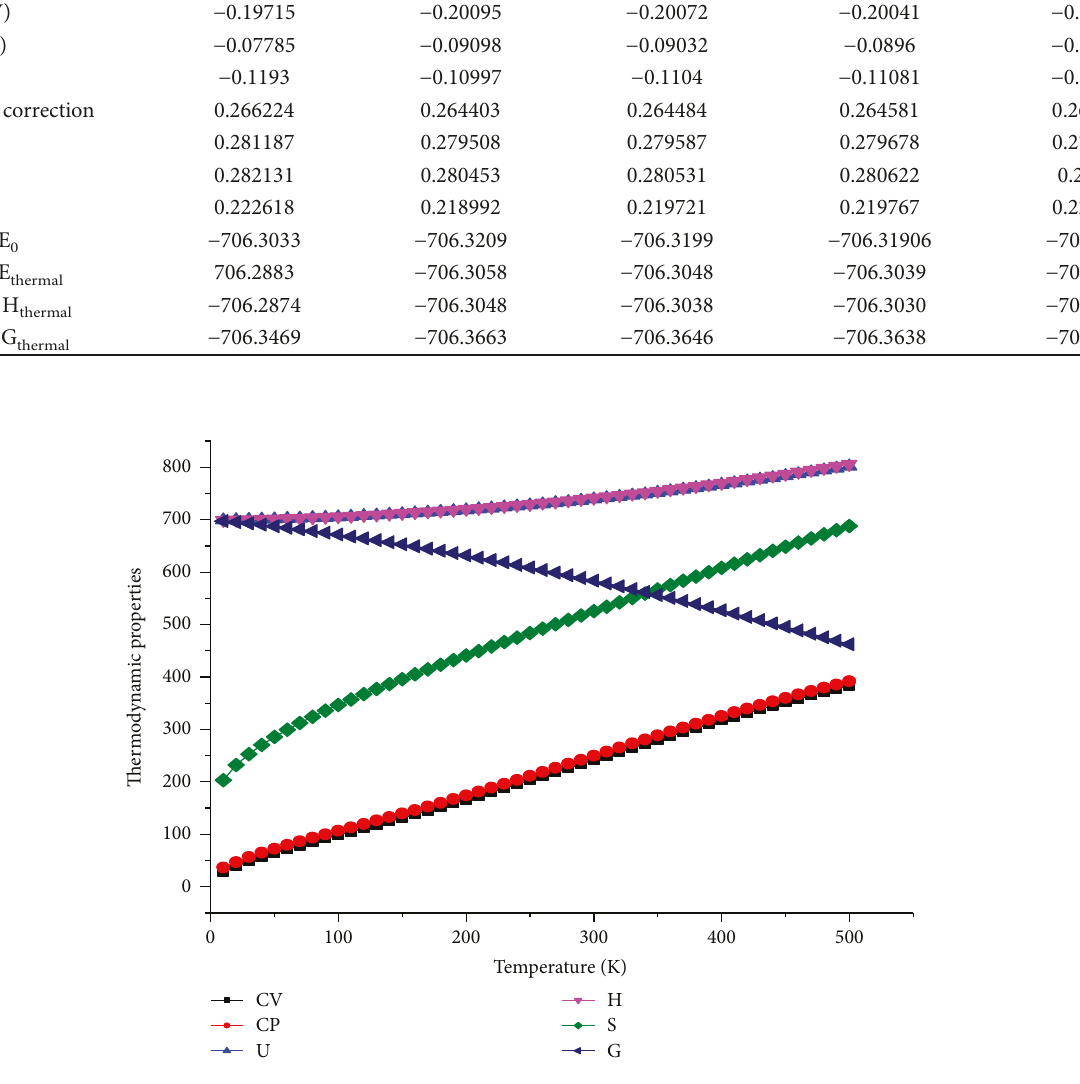
Figure 6: Thermodynamic parameters calculated by a Moltran program for DMAB in the gas phase in temperature range of 0 –